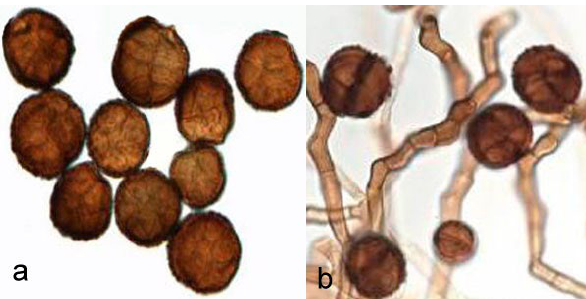
Figure 1. a) Multicellular conidia of Ulocladium atrum , iso- lated from potato leaves. b) Hyphae and conidiaof U. atrum